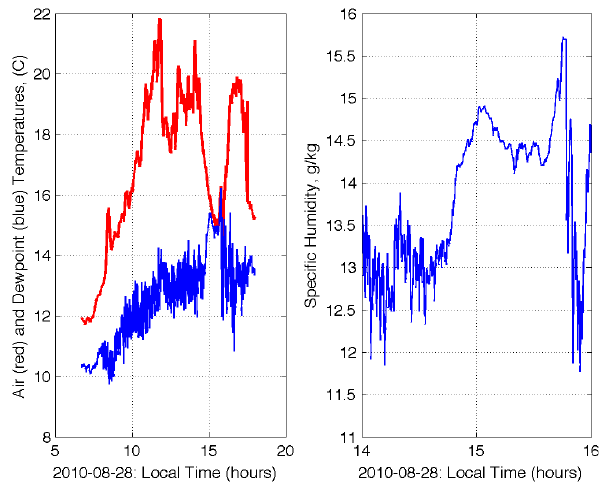
Fig. 12. Left panel: measurements of the temperature and dew point from the chilled mirror hygrometer on Mt. Bigelow. Right panel: specific humidity from 14:00 to 16:00LT.